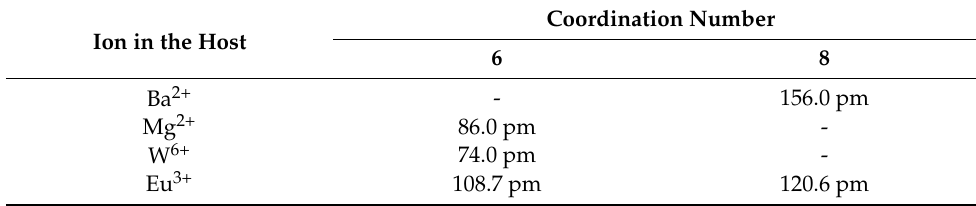
Table 1. Ionic radius values of individual ions in the host.